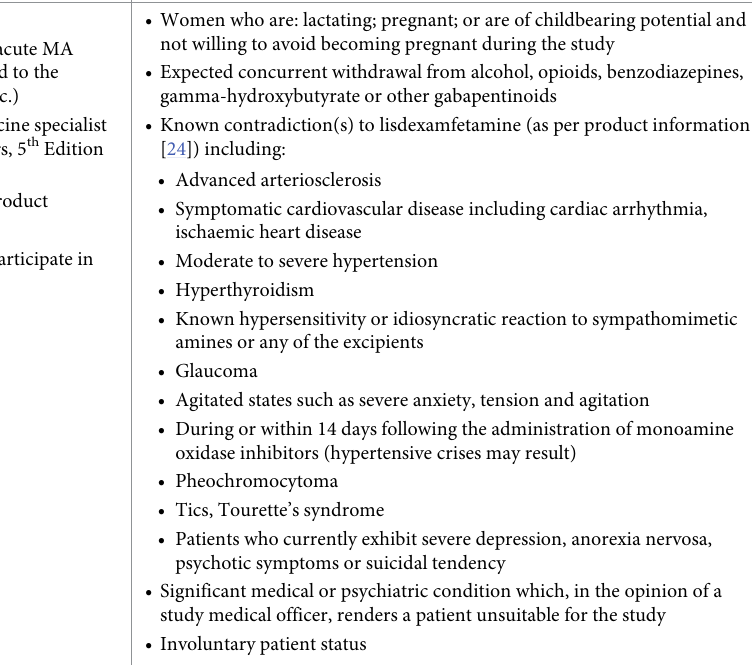
Table 1. Eligibility criteria. Inclusion Criteria Exclusion